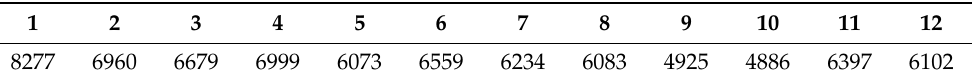
Table 1. The numbers of regions with TRs of different lengths detected in rice